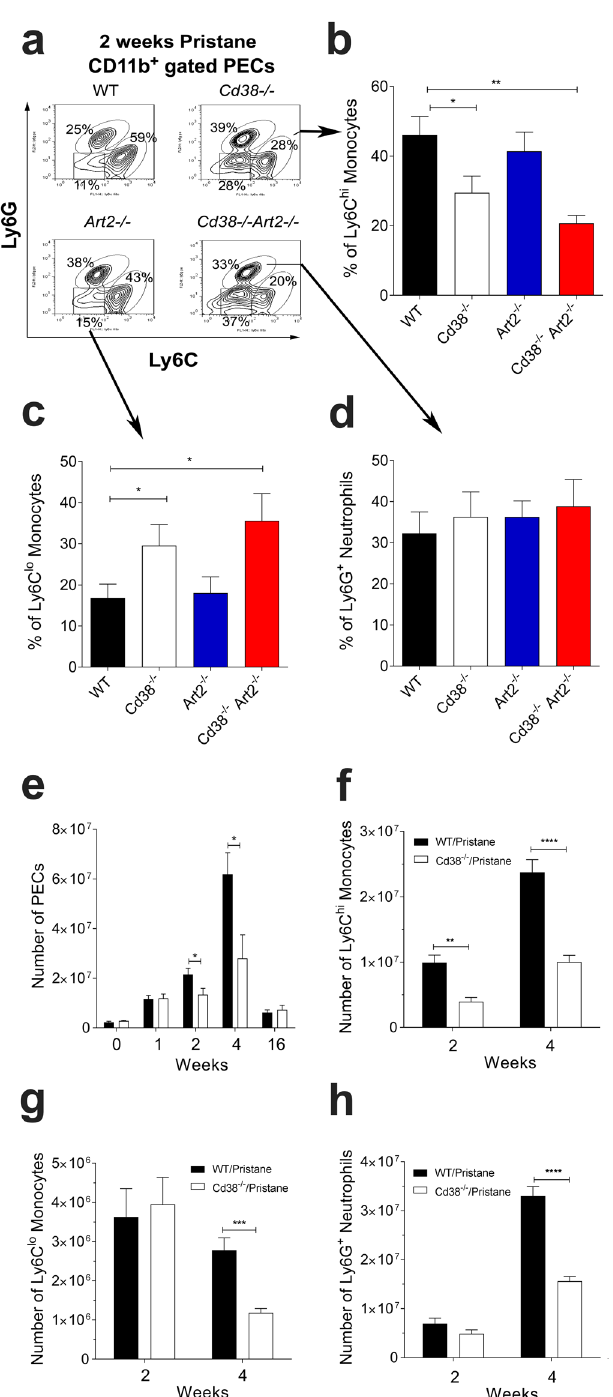
Figure 1. Altered pristane-induced chronic inflammation in Cd38 − / − mice. ( a ) Flow cytometric analysis of Ly6C and Ly6G expression on CD11b + -gated PECs at 2-weeks post pristane treatment. Contour plots show the frequencies of Ly6C hi monocytes, Ly6G + neutrophils, and Ly6C lo monocytes/macrophages as a percentage of total CD11b + PECs from WT, Cd38 − / − , Art2 − / − , and Cd38 − / − Art2 − / − mice. Contour plots shown are representative of 3 independent experiments. ( b–d ) Frequencies of Ly6C hi monocytes ( b ) Ly6C lo monocytes/ macrophages (c) and Ly6G + neutrophils (d) as a percentage of total PECs from WT, Cd38 − / − , Art2 − / − , and Cd38 − / − Art2 − / − mice. Data are shown as the mean ± SE (n = 7–9 mice/group). (e) Absolute numbers of total PECs at 0-, 1-, 2-, 4-, and 16-weeks post pristane treatment. Data are shown as mean ± SE (n = 5–14 mice/ group). (f–h) Numbers of Ly6C hi monocytes (f) , Ly6C lo monocytes/macrophages (g) and Ly6G + neutrophils (h) at 2- and 4-weeks post pristane treatment. Data are shown as the mean ± SE (n = 7–9 mice/group). All P values were determined by 2-way ANOVA with the Dunnett’s multiple comparisons test. * P < 0.05 ** P < 0.01 *** P < 0.001 **** P <